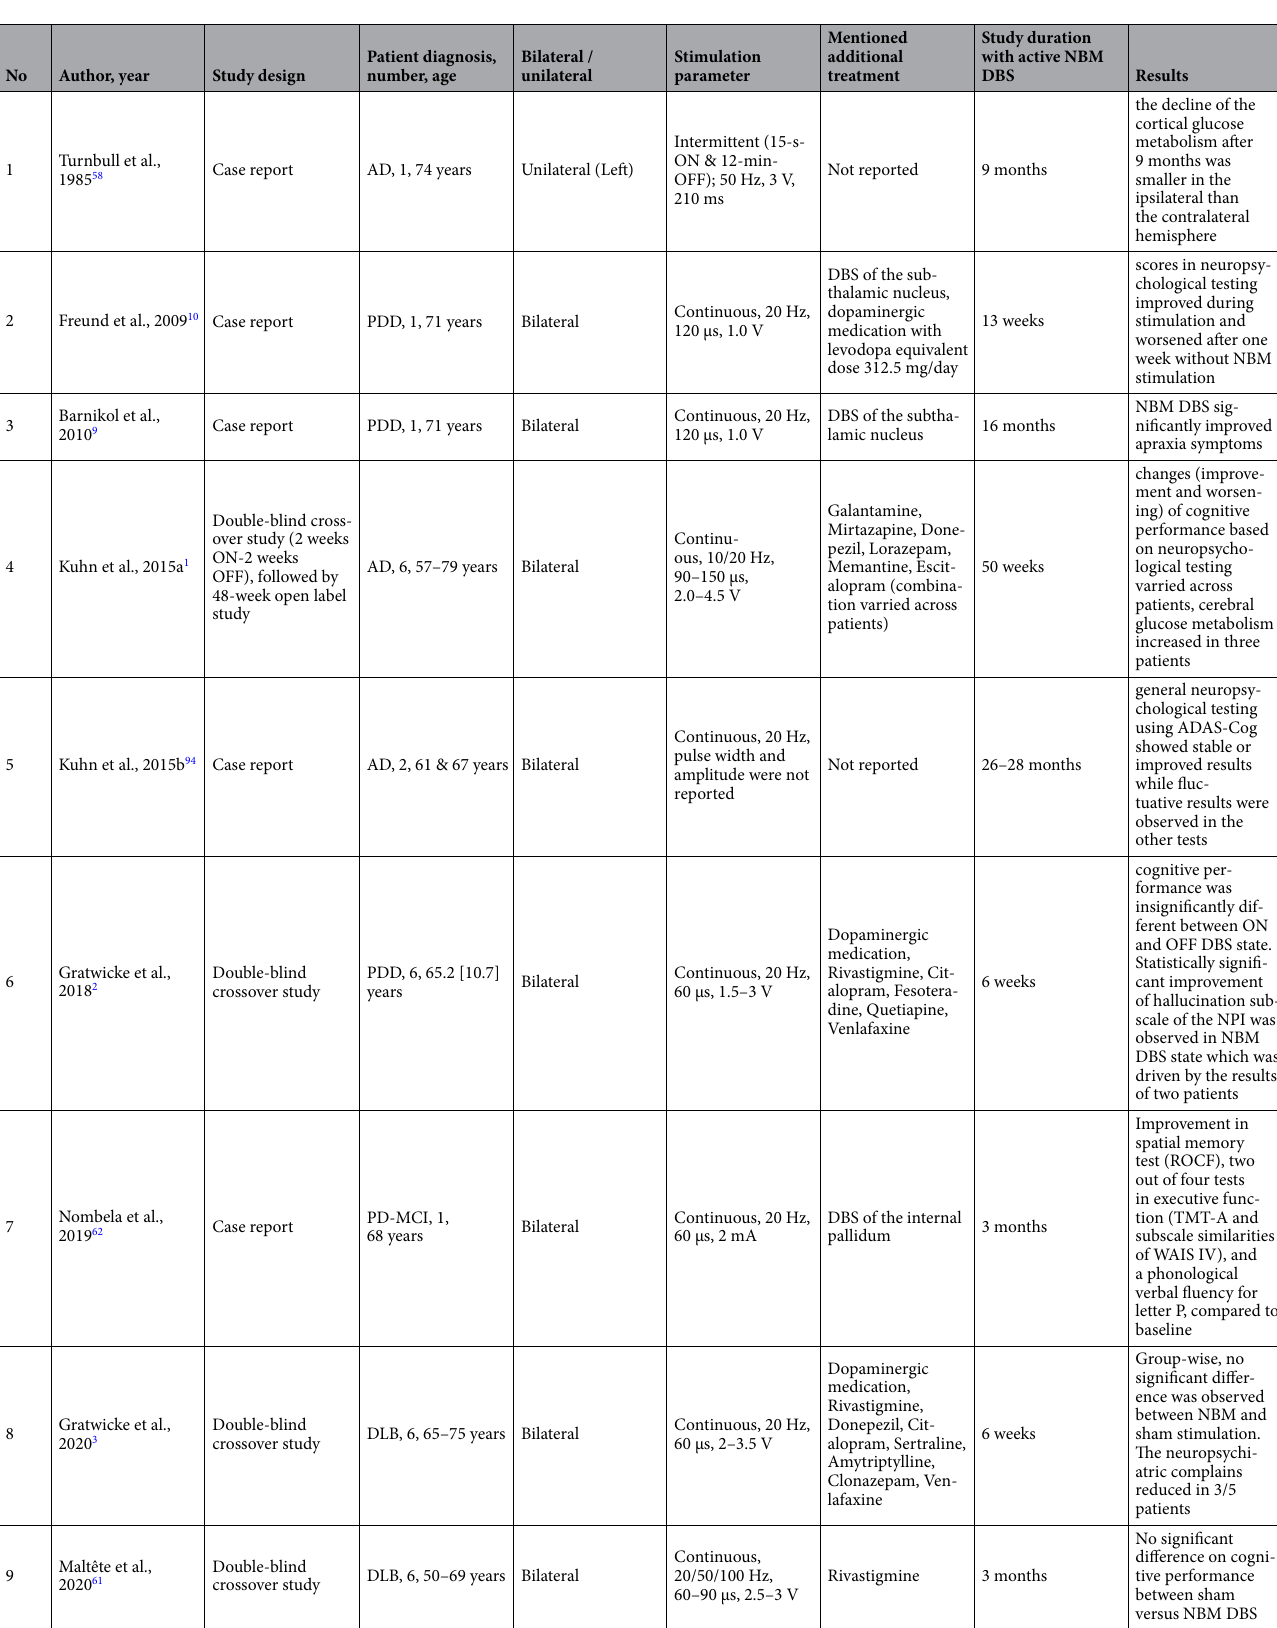
Table 2. Characteristics and results of NBM DBS clinical studies reporting cognitive outcomes. ADAS-Cog Alzheimer’s Disease Assessment Scale Cognitive Subscale, ROCF Rey-Osterrieth Complex Figure, TMT-A Trail Making Test A, WAIS IV Wechsler Adult Intelligence Scale